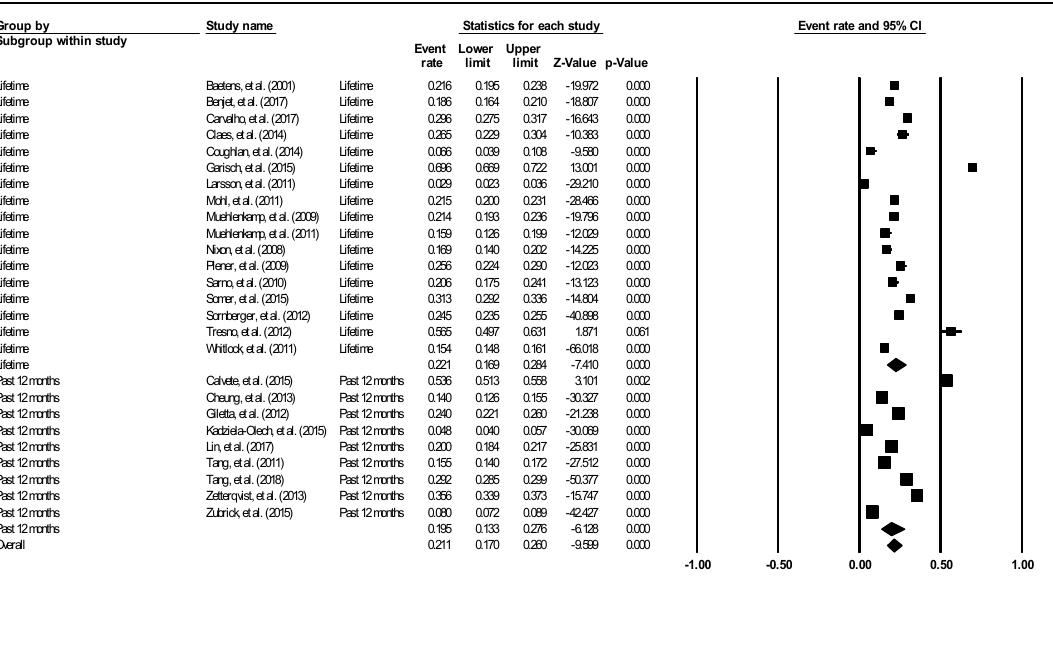
Figure 7. Forest plot of the aggregate lifetime and 12-month prevalence of non-suicidal self-injury. The aggregate lifetime prevalence of deliberate self-harm was 13.7% (95% CI: 10.9–17.1%). The result is demonstrated using the forest plot, as shown in Figure 8.